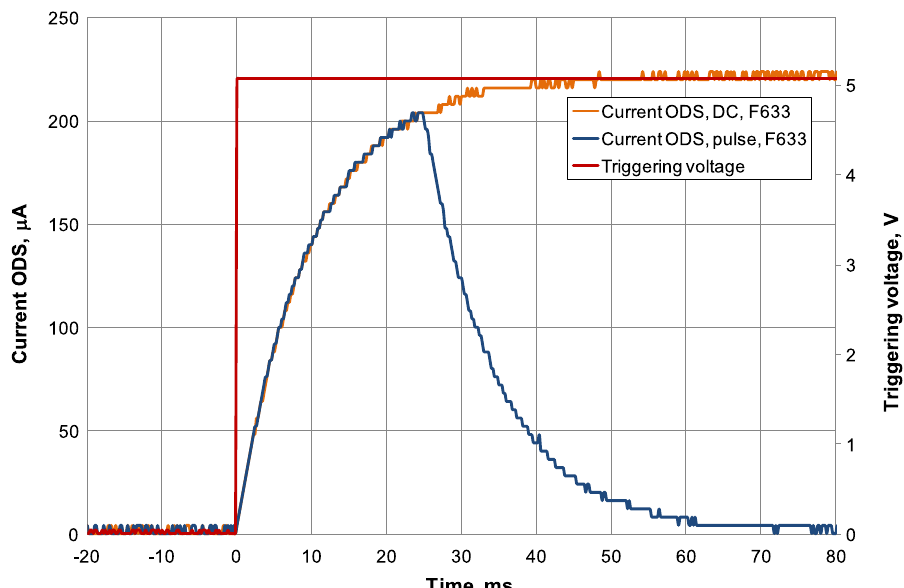
Fig. 14. Comparison of short-pulse and DC-driven resulting optical signal of DUT VSL085 as measured by the fi lter F633 of ODS; triggering voltage is given for reference (secondary